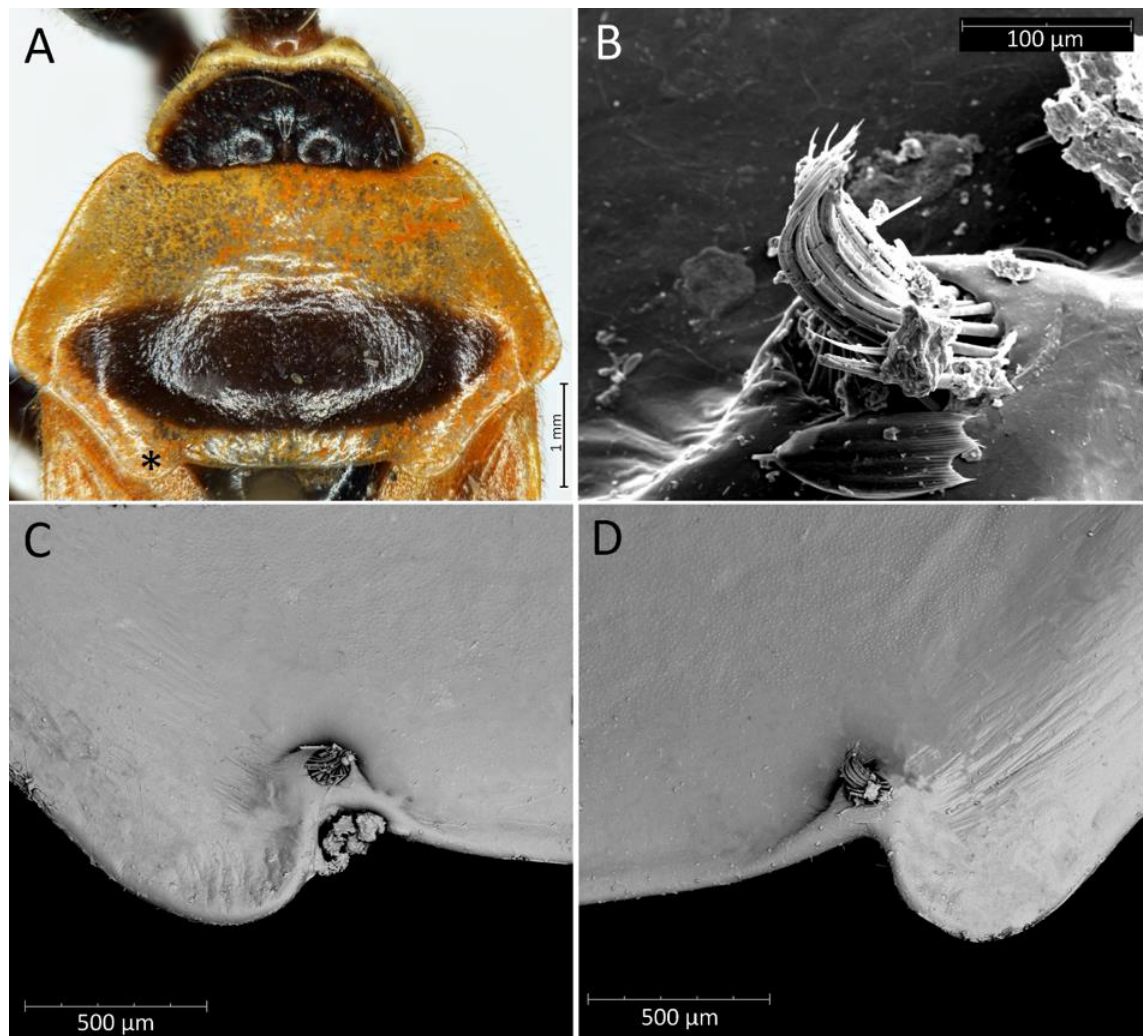
Figure 17. Phonoctonus bifasciatus Villiers, 1948: ( A ) anterior and posterior lobe of pronotum with humeri marked with *. P. fasciatus (Beauvois, 1805): ( B ) magnification of the bunches of sensilla at the underside of the posterior pronotal lobe using secondary electron detector (SED); view of the mentioned bunches of sensilla ( C ) on the right and ( D ) on the left side of the pronotum.